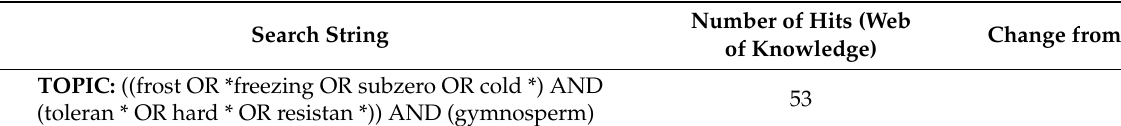
Table A1. Results of exploratory search in Web of Knowledge, done on 20 November